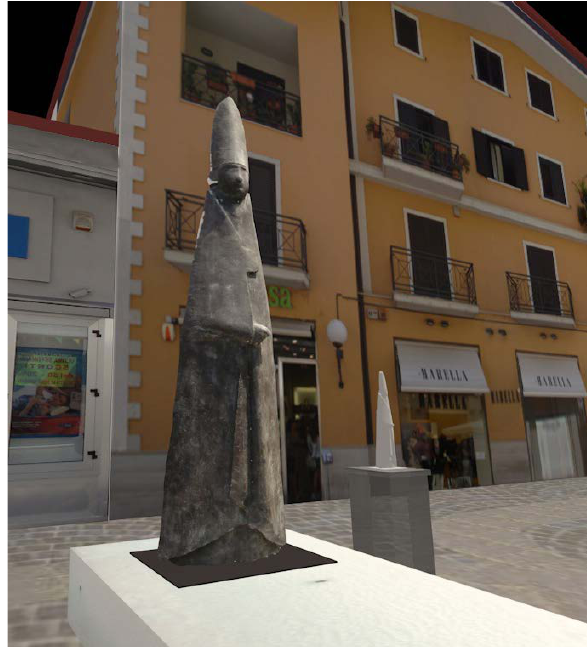
Figure 19. The models of The great Cardinal standing and of the miniature in the new position.